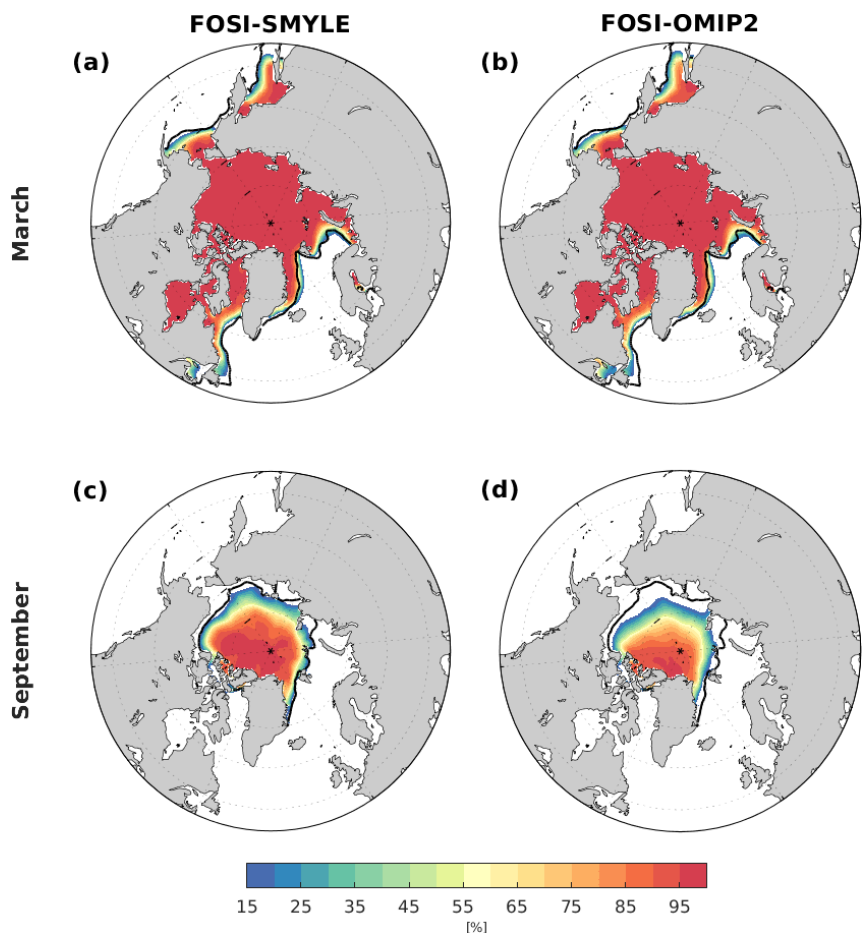
Figure A2. Climatological (1991–2010) sea ice concentration for March (top) and September (bottom) from (a, c) SMYLE-FOSI and (b, d) FOSI-OMIP2. Black contour line shows the observed sea ice extent (15% concentration) from satellite observations (Comiso, 2017) averaged over the same climatology. Note that the color scale starts from